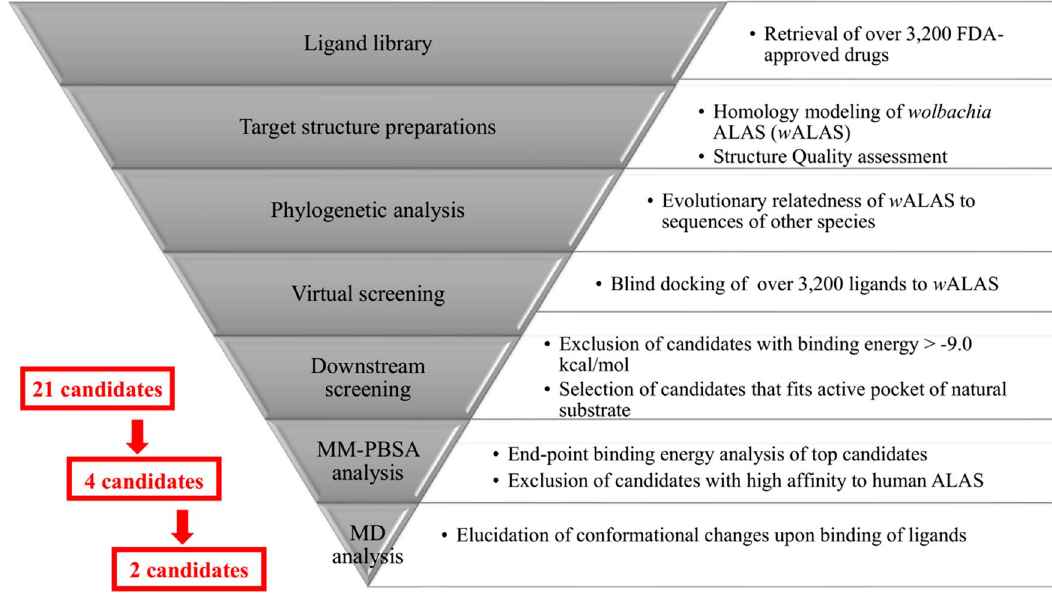
Figure 1. Flowchart depicting the in silico drug repurposing approach for the